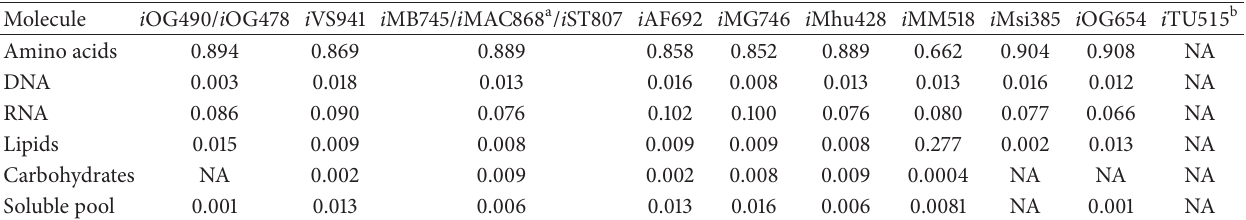
Table 2: Cellular Molar Fractions . The composition of each Archaea’s biomass organized by major categories. Molecule Amino acids